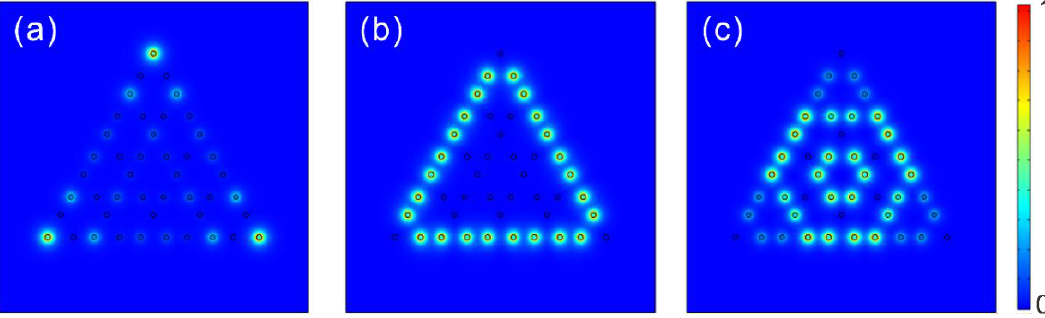
Figure 3. The typical modal profiles (| E |) for the different types of modes. ( a ) Corner mode, ( b ) edge mode, and ( c ) bulk mode.